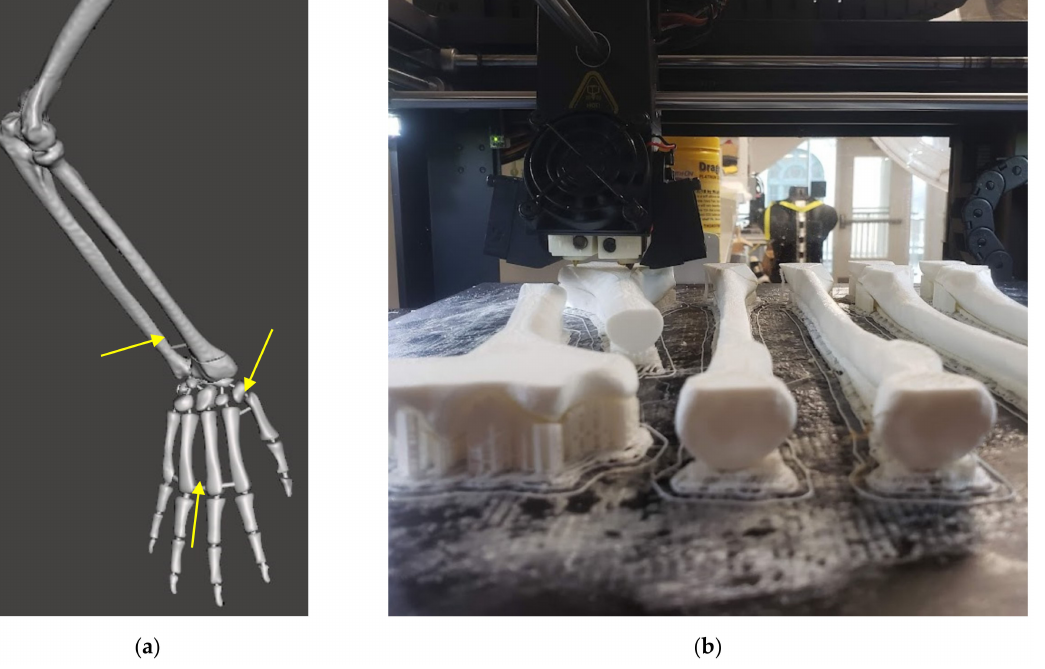
Figure 5. ( a ) Photograph showing the modified bone model in Meshmixer. Individual bones are fixed to one another with small pins, examples identified with yellow arrows. The phantom created for this study also incorporates a DRF modification, circled in red. ( b ) Sample long-bones of the phantom skeleton being printed with the Raise3D FDM machine.